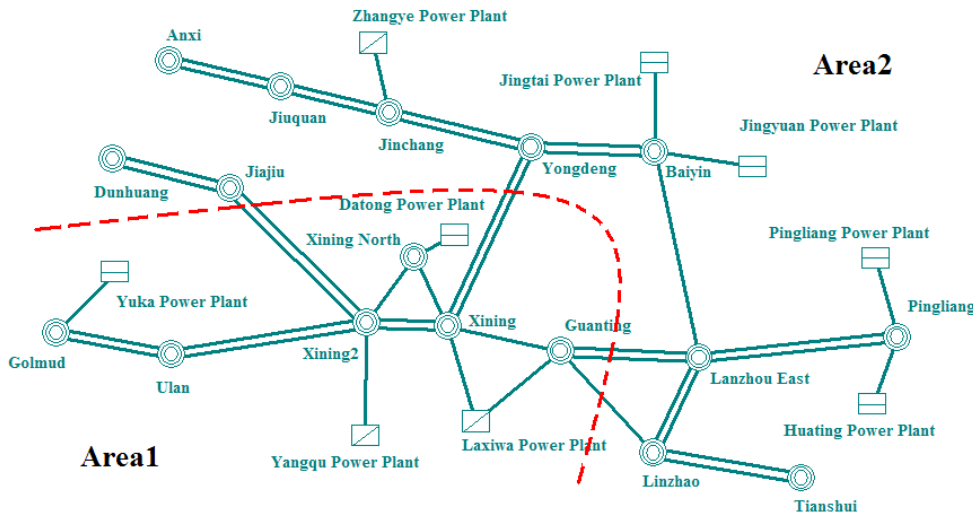
Figure 5. 750 kV planning network of two regions in Northwest